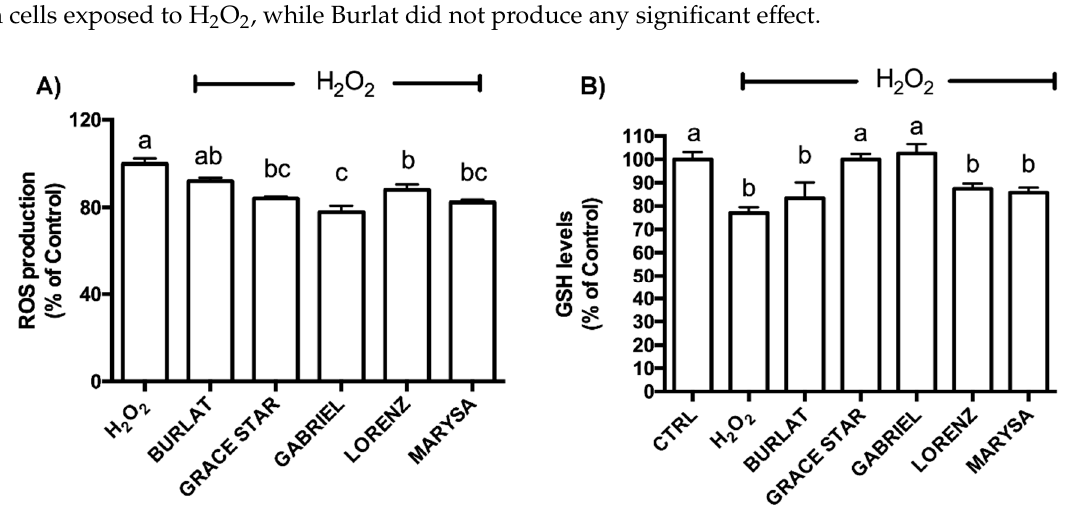
Figure 7. Effects of cherry extracts on intracellular ( A ) reactive oxygen species (ROS) and ( B ) reduced glutathione (GSH) levels in SH-SY5Y cells. ROS data are expressed as a percentage compared to H 2 O 2 -treated cells, and GSH levels are expressed as a percentage compared to control (CTRL) cells; each bar represents the mean ± SEM of at least three independent experiments. Different letters indicate statistical significance ( p < 0.05).